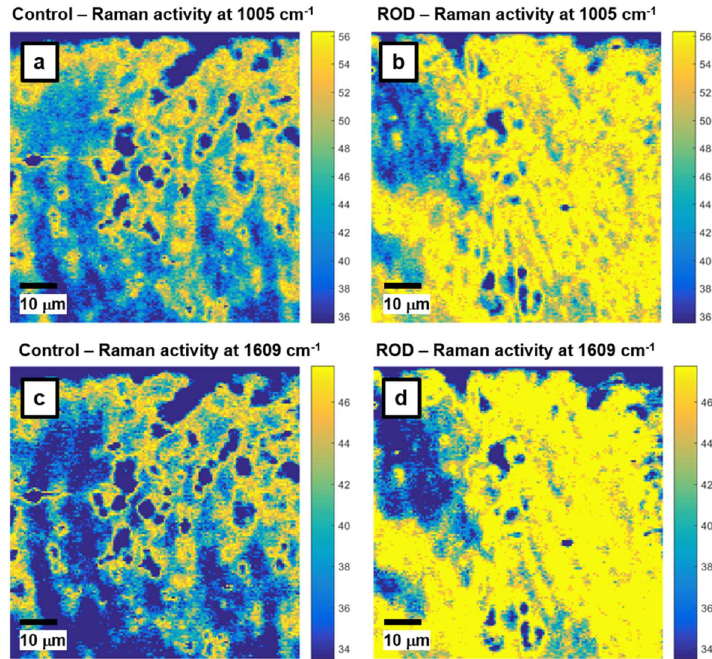
Figure 2. Raman mapping images of phenylalanine activity: ( a , b ) with the 1005 cm − 1 vibrational line, and ( c , d ) with the 1609 cm − 1 band for control and ROD bone samples, respectively. A bright yellow pseudo-color corresponds to a higher